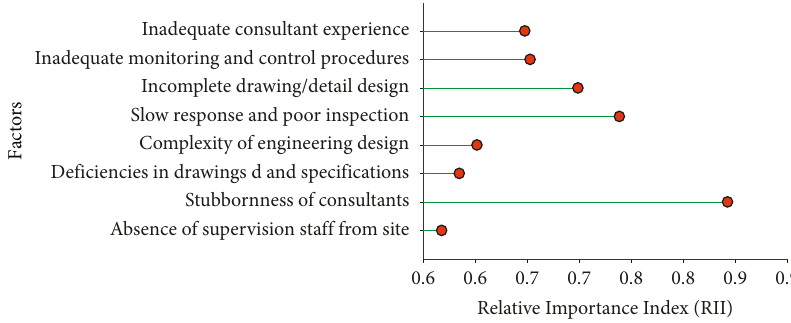
Figure 3: Ranking of consultant-related